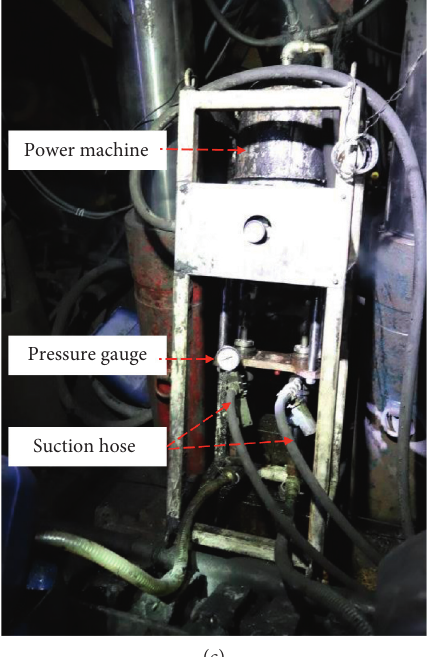
Figure 11: 1508 Working Face site construction. (a) Process diagram. (b) Site construction. (c) Multifunctional grouting pump.